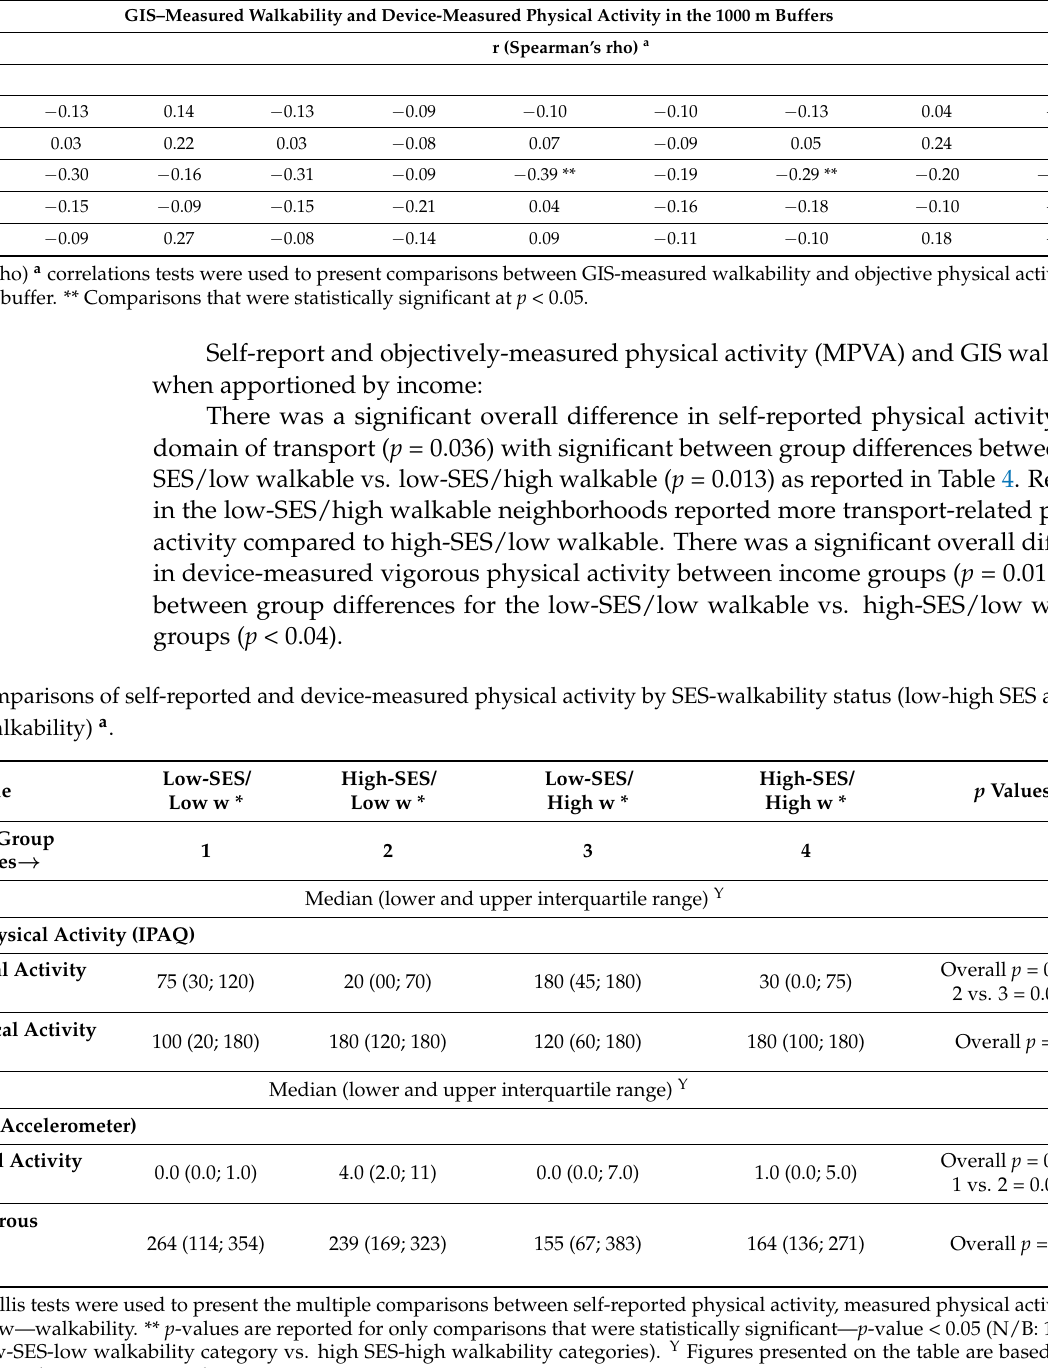
Table 3. GIS-measured walkability and device-measured physical activity in the 1000 m buffers. SES GIS–Measured Walkability and Device-Measured Physical Activity in the 1000 m Buffers r (Spearman’s rho) a